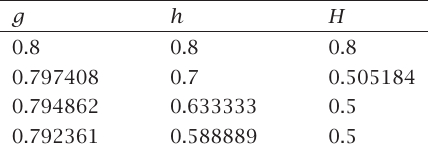
Table 4.1 . h = C(x,f) , H = C(g,h)